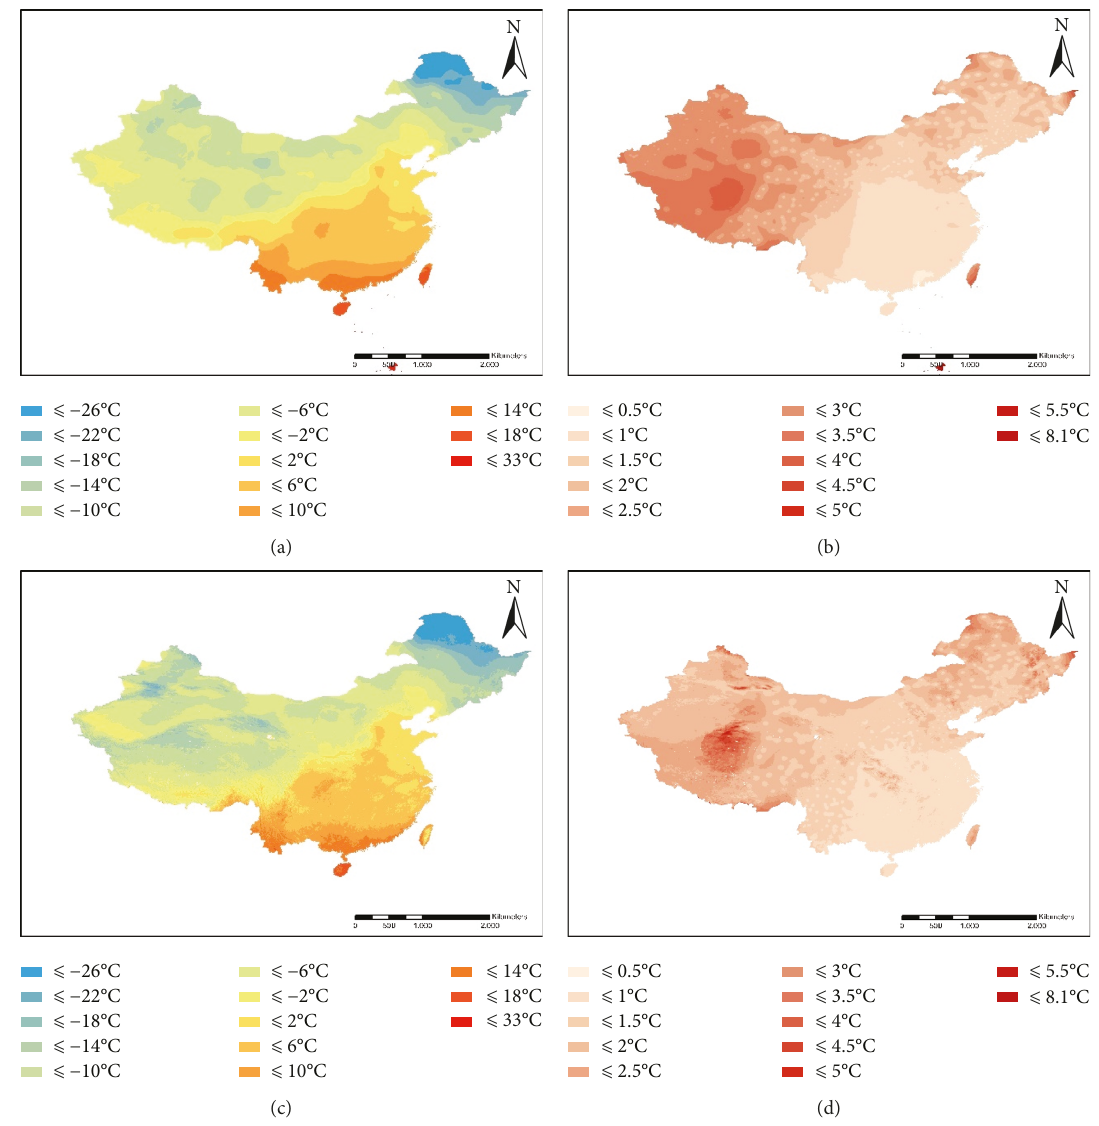
Figure 9: WS interpolation maps of T